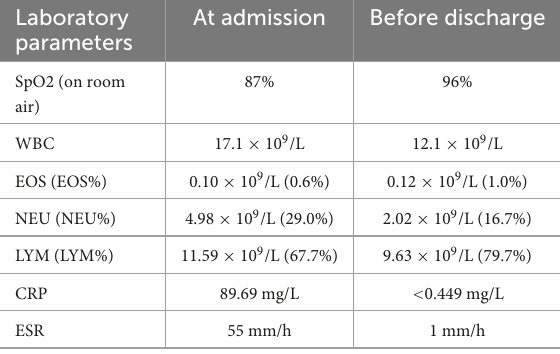
TABLE 1 Laboratory parameters of patients at admission and before discharge. Laboratory